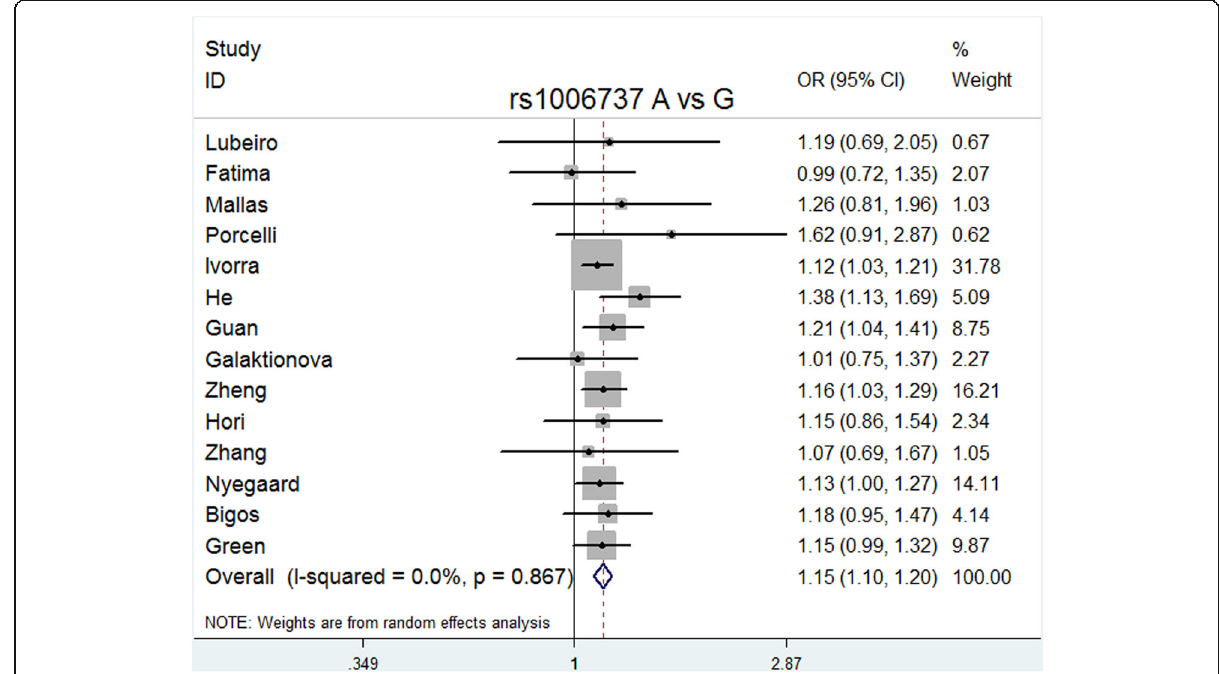
Fig. 2 Forest plot of the allele contrast model (A vs. G) for rs1006737. Significant differences between rs1006737 and the risk of schizophrenia were observed with the allele contrast model (T vs. G) (OR = 1.151, 95% CI = 1.100 – 1.204, P heterogeneity = 0.867, P = 0.000)